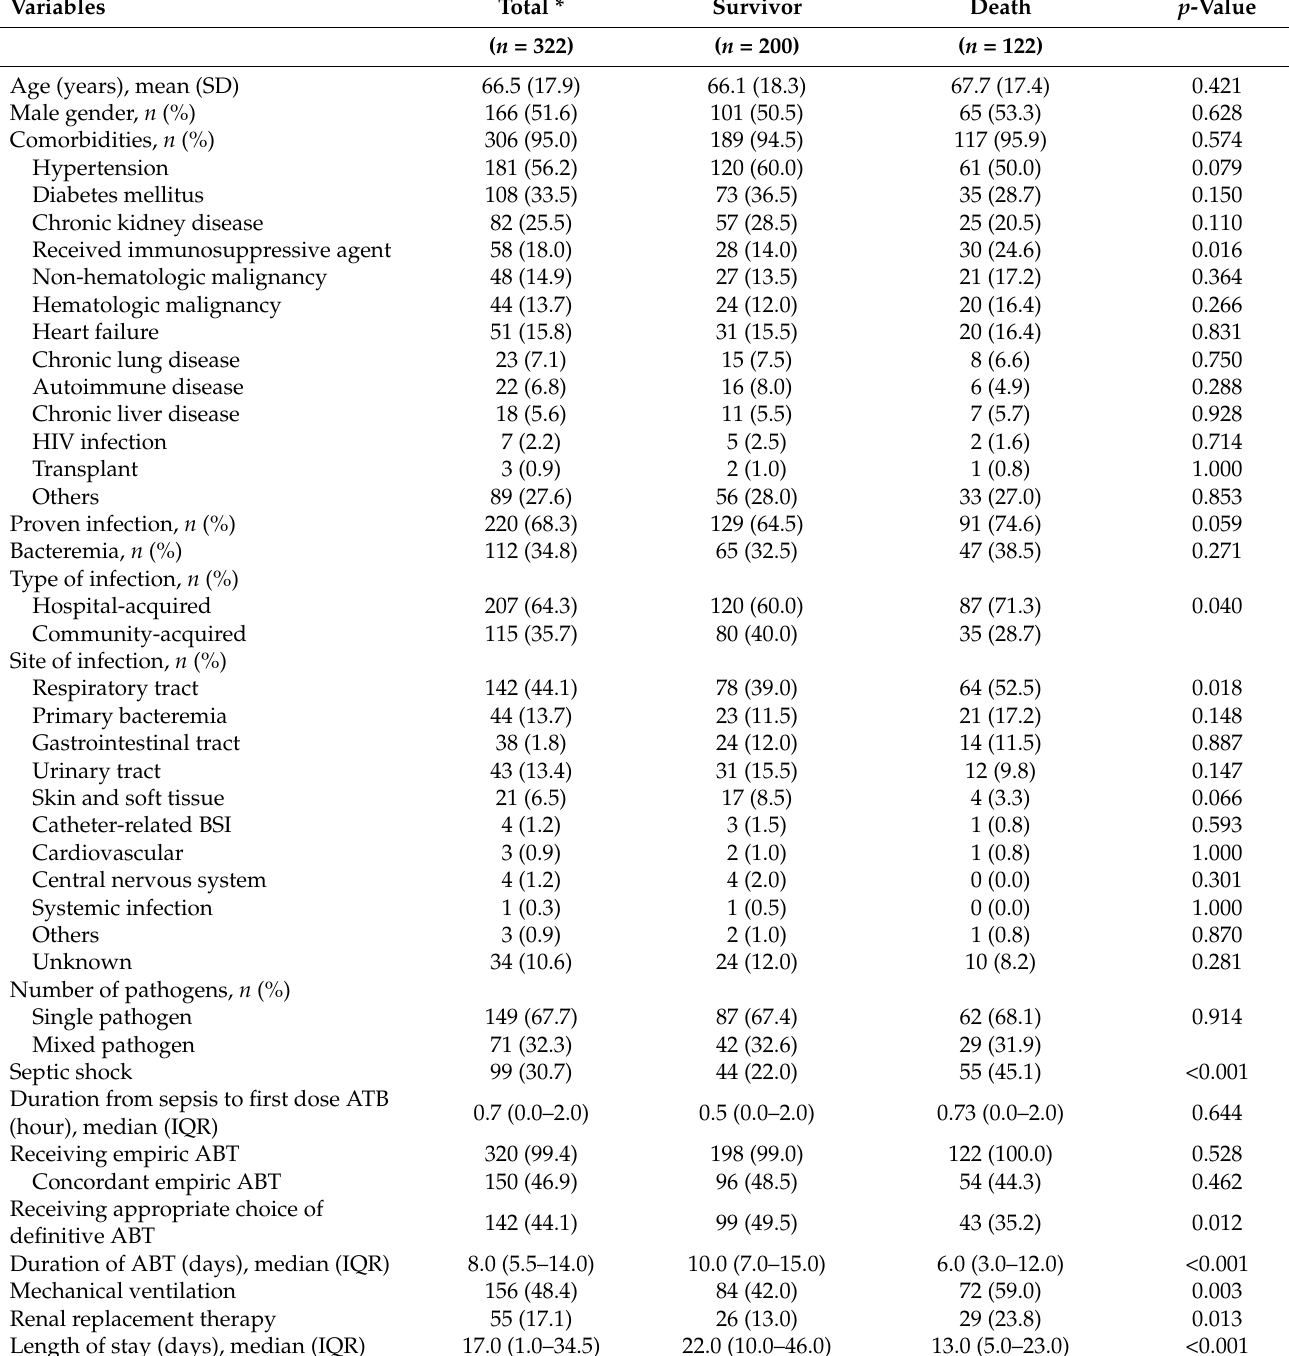
Table 2. Characteristics of all patients with sepsis or septic shock, and a comparison between those who survived and those who died within 28